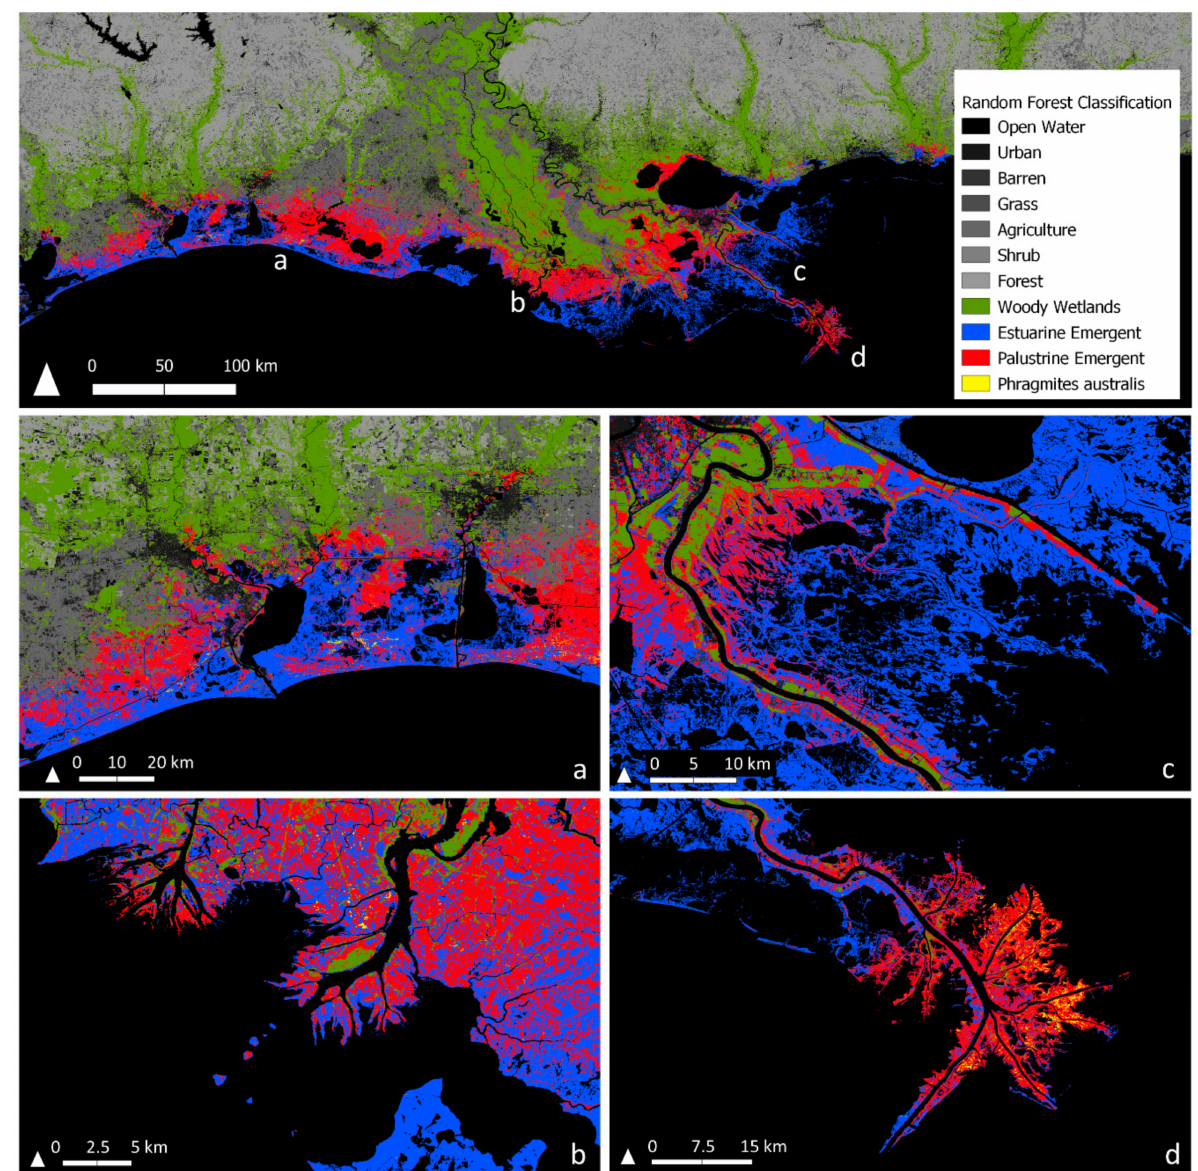
Figure 12. Gulf Coast level-1 classification using random forest. Panels a – d depict finer scale maps of the Sabine River wetlands ( a ), Wax Lake Delta wetlands ( b ), Brenton Sound wetlands ( c ), and Bird’s Foot Delta wetlands ( d ). Classification accuracy of the three emergent classes is much lower than Mid-Atlantic sites at around 70% (see Table 4 confusion matrix). However, the aggregation of these three emergent classes into a single emergent class yields accuracies higher than the Mid-Atlantic with a user’s accuracy of 91.81% and producer’s accuracy of